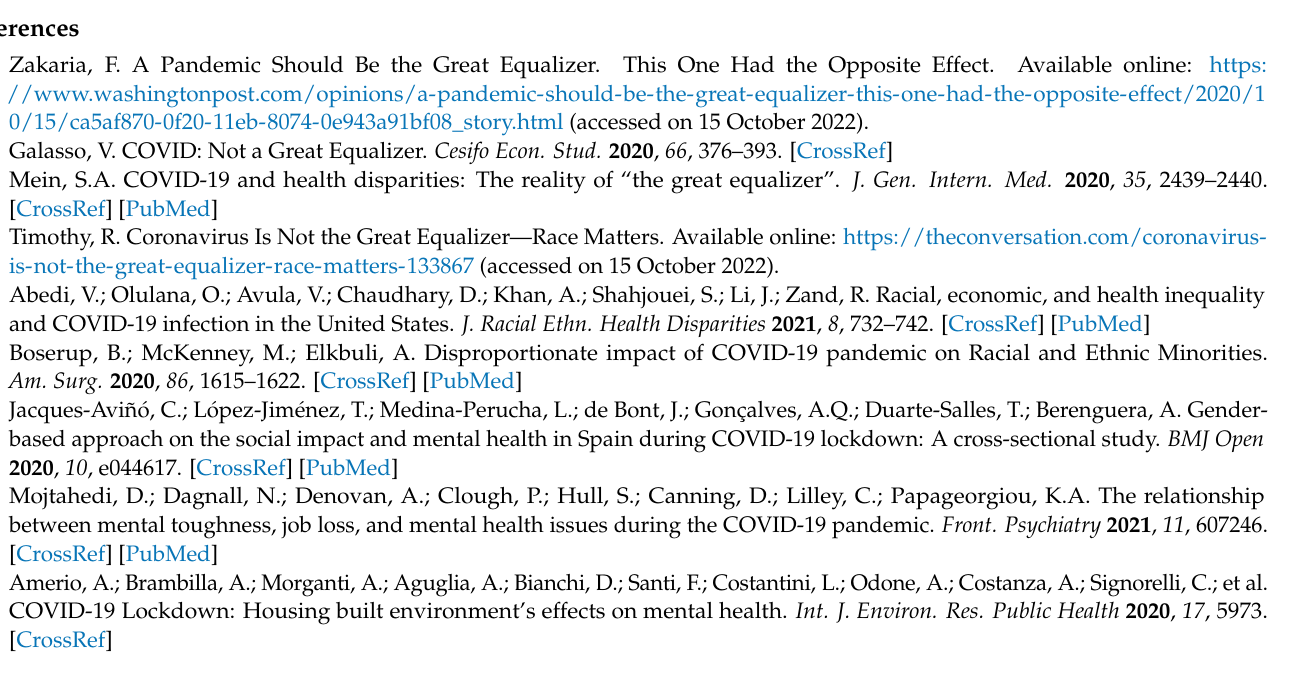
Table S4: Full regression model for factors associated with moderate, and severe anxiety compared to mild anxiety, Table S5: Full regression model for factors associated with moderate, and severe depression compared to mild depression, Table S6: Full regression model for factors associated with mental health support seeking behavior (needed support and received, needed but no access) compared to did not need and did not